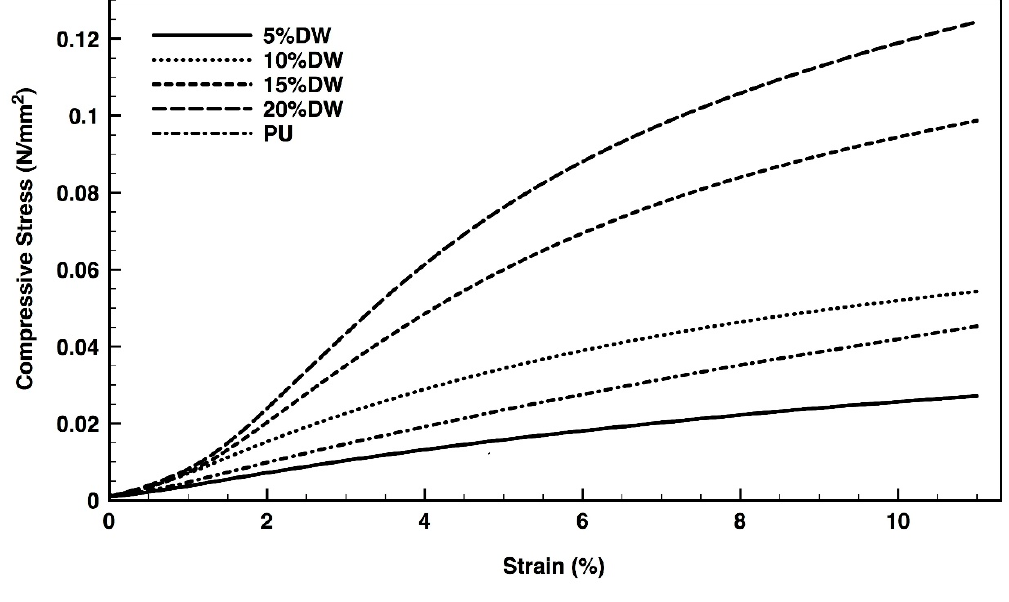
Figure 8. Compressive stress versus strain of the pristine PU and the dog wool-reinforced eco- composites.